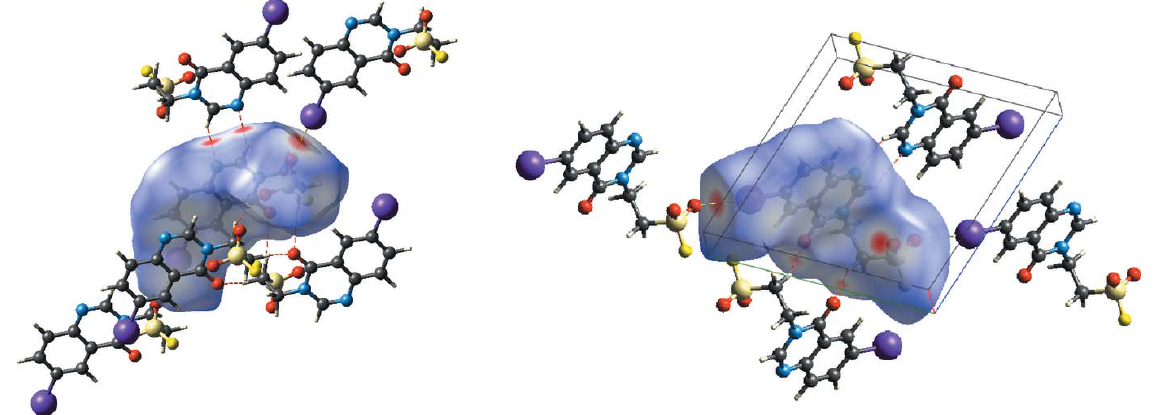
Figure 4 Different aspects of the three-dimensional Hirshfeld surface of (I) mapped over d norm . Red spots indicate shortened contacts, revealing intermolecular hydrogen and halogen bonds